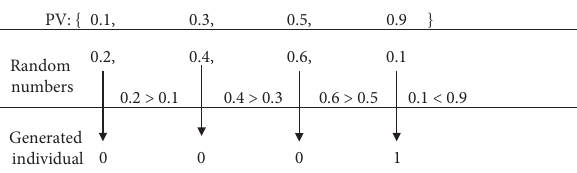
Figure 2: An example of generating an individual through PV.